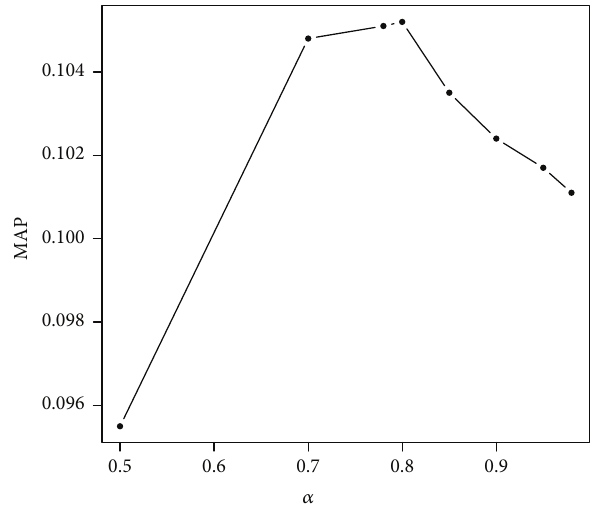
Figure 4: MAP distribution for INEX SBS 2014 when varying the interpolation parameter 𝛼